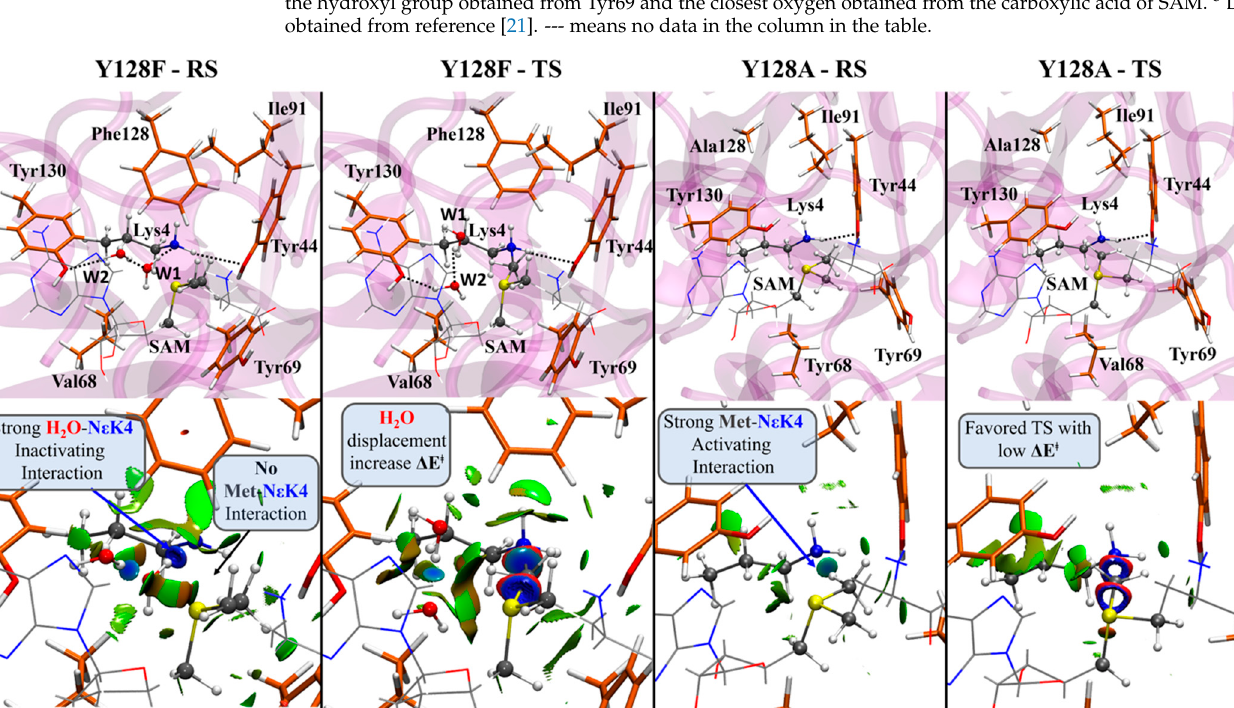
Figure 1. Structural representation of the catalytic site at RS and TS for the mono-methyl transfer reaction performed by the Y128F and Y128A mutants. Below, there is a graphic representation in real space of the non-covalent interactions occurring between the methyl group and the enzymatic environment, showing the mechanism for the inactivation of the Y128F mutant ( Δ E ≠ stands for barrier heights; enzyme’s carbon—orange; substrate and cofactor carbon—gray; red—oxygen; blue— nitrogen; white—hydrogen; and the isovalue used as cutoff for the surface was defined as 0.5). Table 1. Barrier heights ( Δ E ≠ ), reaction energies ( Δ E 1 °), and selected average geometric parameters with their corresponding standard deviations for the RS and TS conformations of the mono-methyl- transfer reaction in the native enzyme M3RA and mutants Y44F, Y128F, Y44A, Y128A, Y69F, and Y130F. Average activation and reaction energies are in kcal/mol, distances in Å, and angles in de- grees (°).